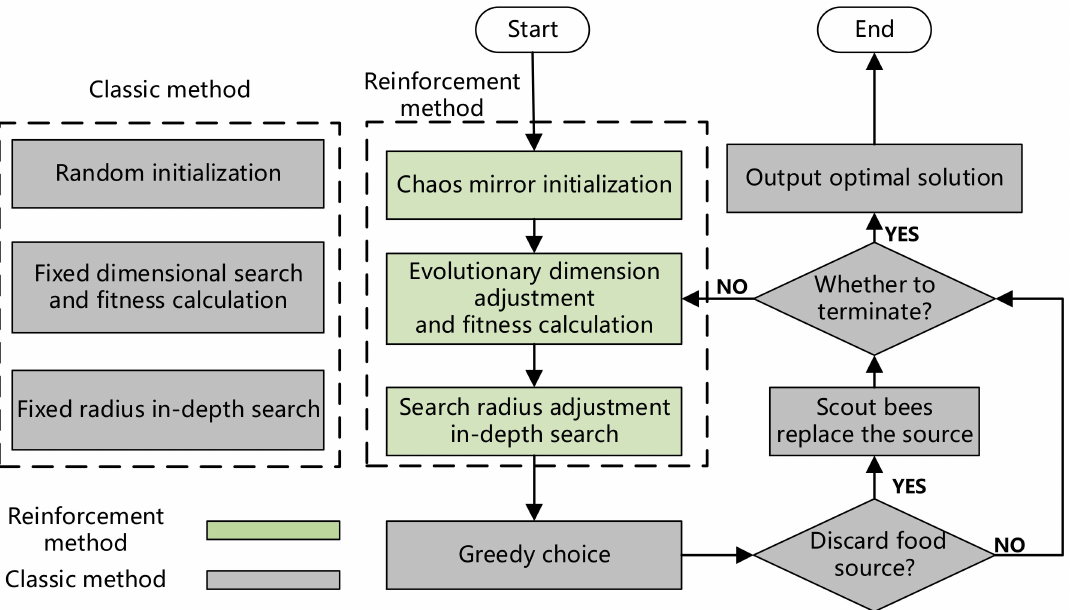
Figure 11. Comparison of classic method and reinforcement